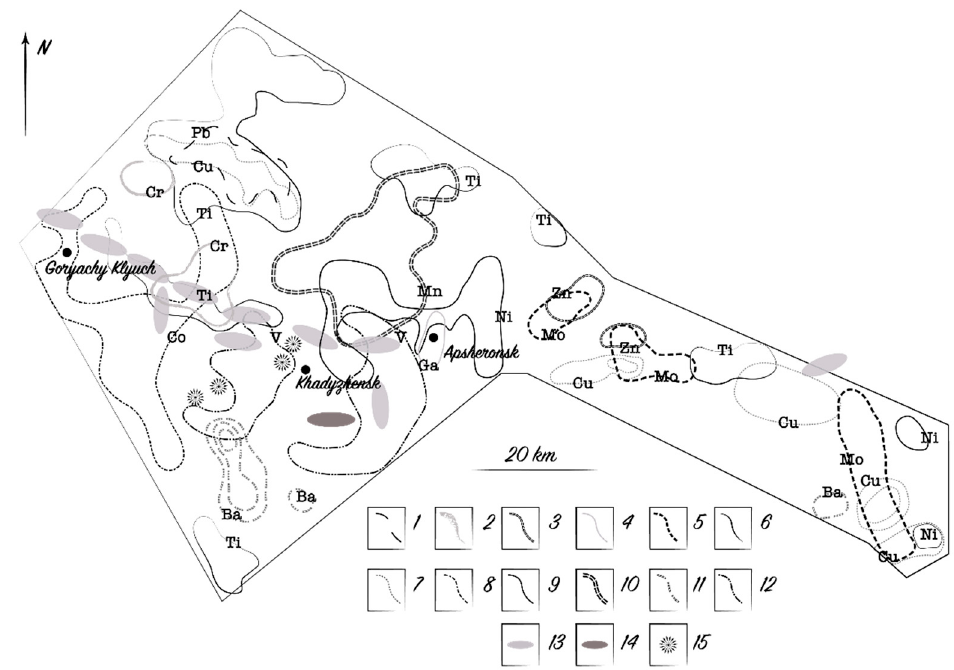
Figure 1. Secondary pedochemical metal anomalies over the partially overlapping mercury, oil, and gas fields. Symbols: 1—Pb; 2—Cr; 3—Zn; 4—Ga; 5—Mo; 6—Ti; 7—Cu; 8—Co; 9—Ni; 10—Mn; 11—Ba; 12—V; 13—gas field; 14—oil field; 15—mercury deposit.